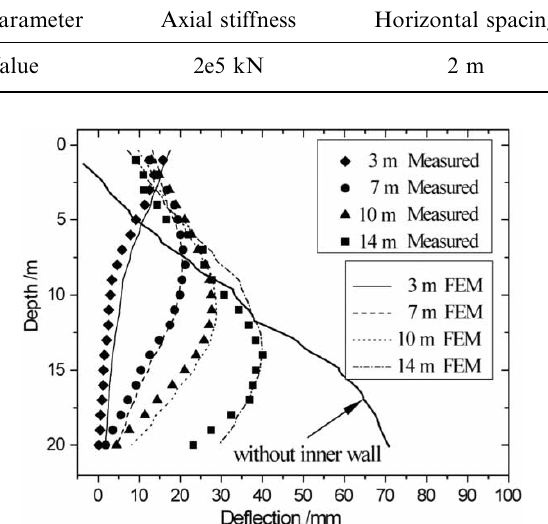
Fig. 5. Comparison of measured and calculated outer wall deflections for different excavation depths